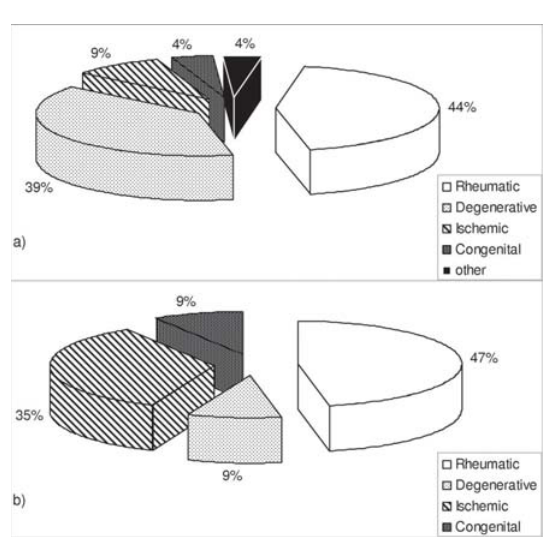
Fig. 2 – A: Chart disclosing the mitral valve pathologies in the adult population. B: Chart showing the mitral valve pathologies in the pediatric